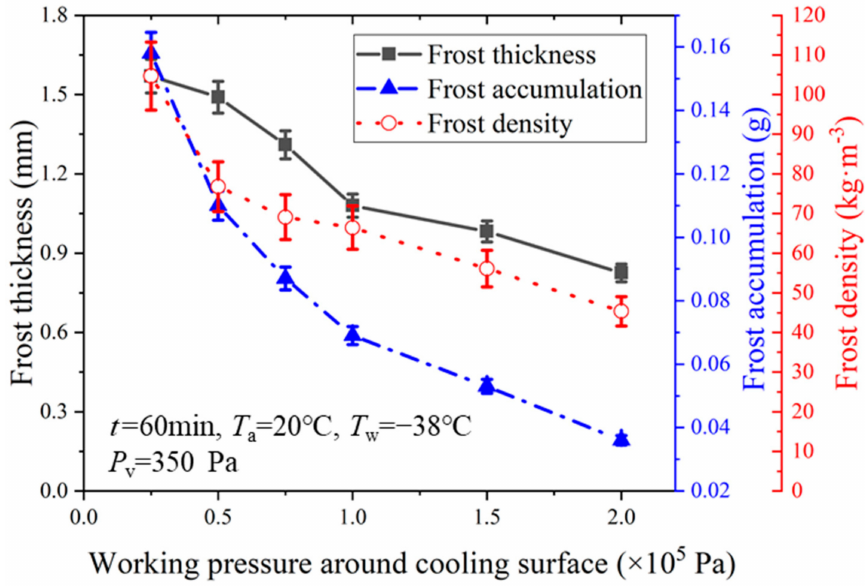
Figure 7. Frost characteristics with different working pressures around cooling surface at 60 min.